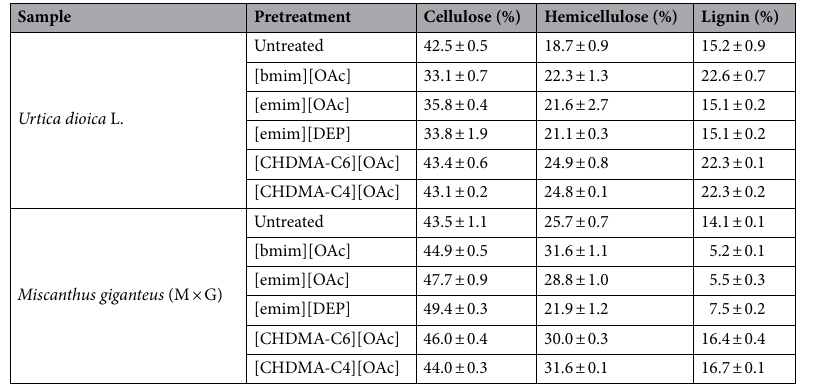
Table 1. Composition of stinging nettle and giant miscanthus untreated and treated with